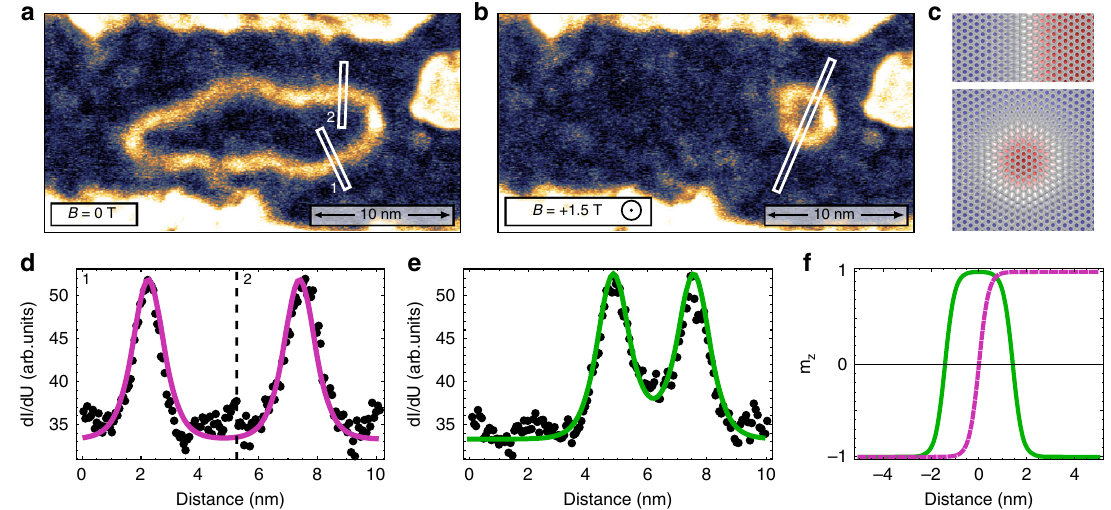
Fig. 3 Domain wall width and skyrmion diameter. a , b dl/dU maps of an isolated magnetic object in Rh hcp /Co/Ir(111) at zero fi eld and at B =+ 1.5T measured with a non-spin-polarized tip; because of the NCMR contribution the DWs have a higher signal than the FM domains ( U = − 250mV, I = 800pA, T = 4K, Cr bulk tip, color gradient as in Fig. 1). c sketches of a DW and a skyrmion ( w = 0.8nm), the color of the atomic magnetic moments indicates the out-of-plane magnetization component. d , e dl/dU signal (dots) across the two DWs in a and the skyrmion in b positions are indicated by the white rectangles; the solid lines are pro fi les of STM simulations of the DW and skyrmion shown in c . f Corresponding out-of-plane magnetization component m z across the DW (magenta) and the skyrmion (green) of